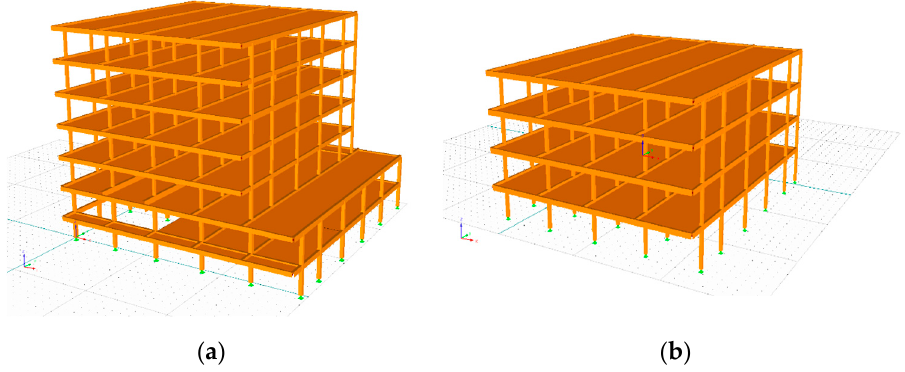
Figure 5. FE model of buildings: ( a ) model of building A; ( b ) model of building B.